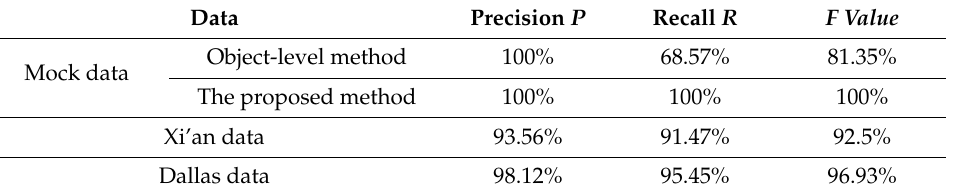
Figure 8. Matching results of the Xi’an and Dallas data: ( a ) the matching results for the Xi’an data with obvious scale differences; ( b ) the matching results for the Dallas data with uncertain scale differences. Table 2. Matching accuracy statistics of precision, recall, and F value.